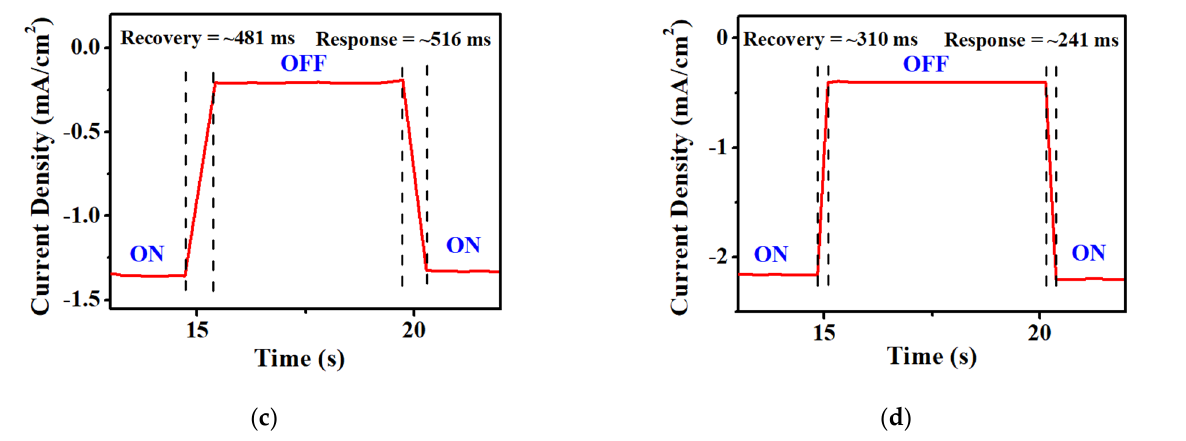
Figure 9. Photo-response of ( a ) VTTBNc:PC 61 BM blends, ( b ) VTTBNc:PC 71 BM blends, ( c ) optimized VTTBNc:PC 61 BM (1:1.5) ( d ) and optimized ratio VTTBNc:PC 71 BM (1:1.0). Table 3. Response and recovery time of the OPDs measured at − 1 V bias.